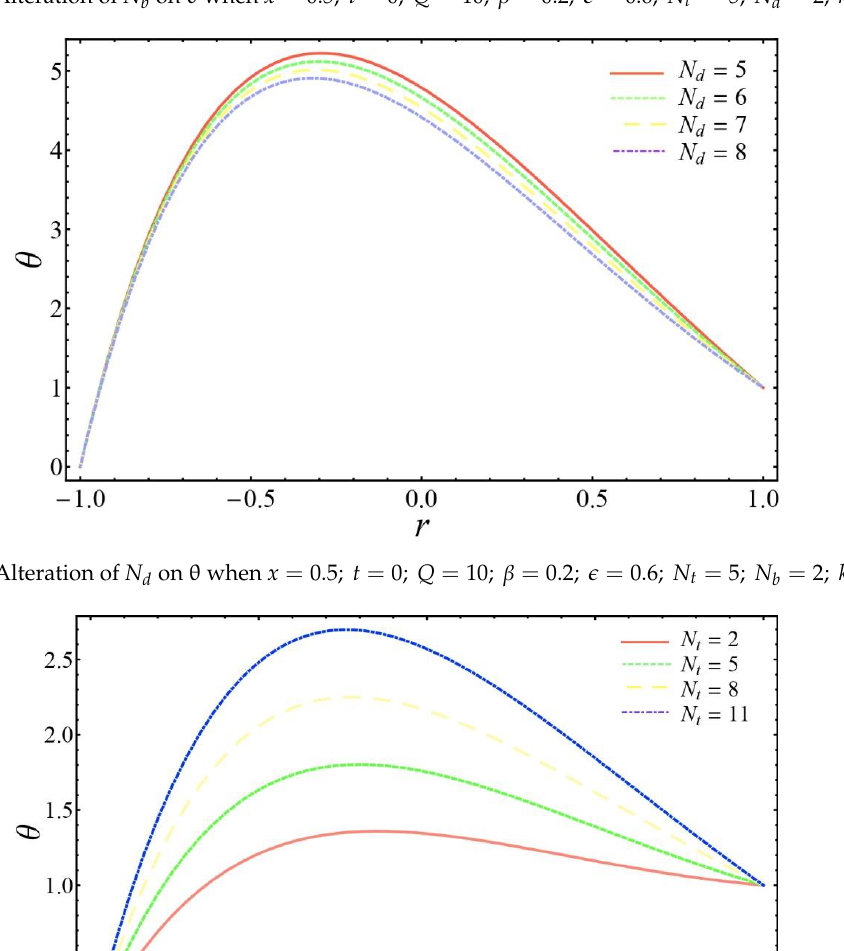
Figure 5. Alteration of 𝑁 𝑏 on θ when 𝑥 = 0.5; 𝑡 = 0; 𝑄 = 10; 𝛽 = 0.2; 𝜖 = 0.6; 𝑁 𝑡 = 5; 𝑁 𝑑 = 2; 𝑘 = 2. Coatings 2020 , 10 , x; doi: FOR PEER REVIEW